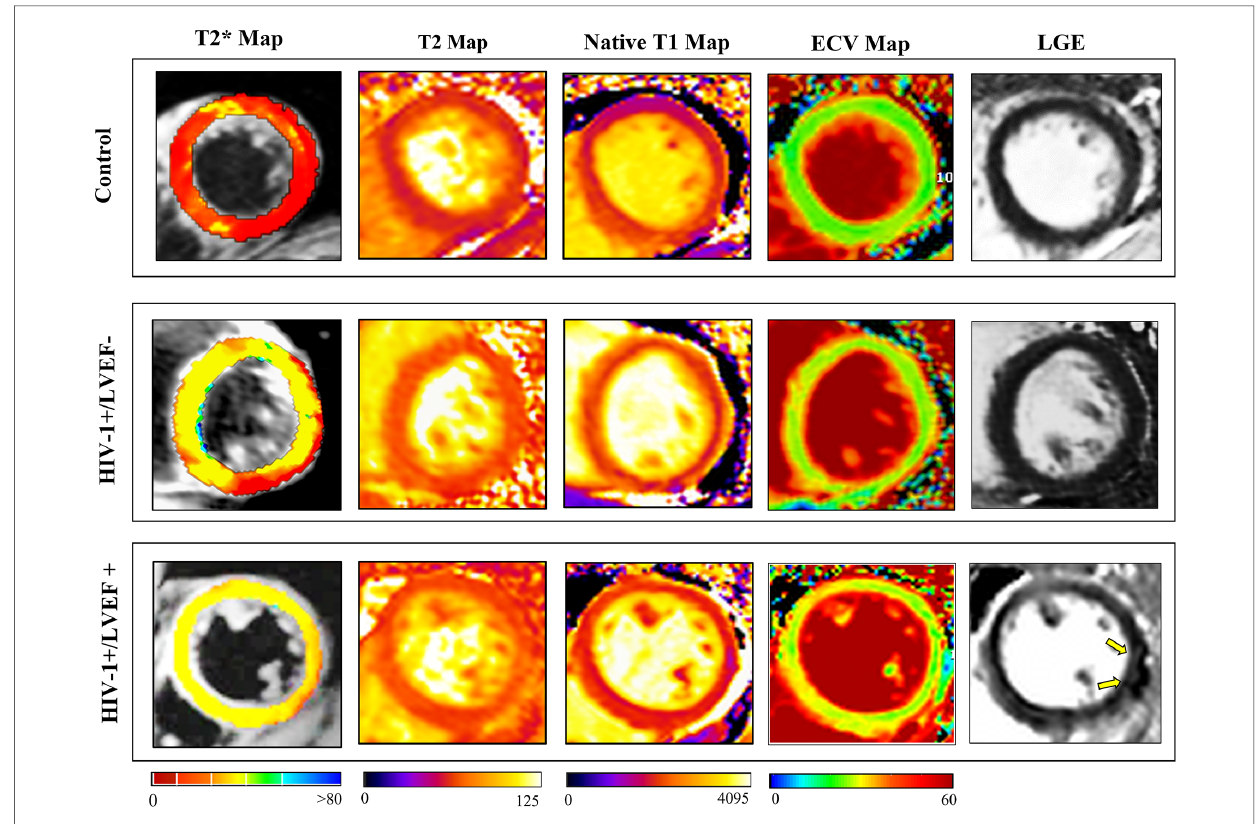
FIGURE 2 Representative clinical examples of CMR images (T2*, T2, T1 native, ECV and LGE) obtained from a healthy subject (control, 35-year-old male), LVEF= 60.3% (top row), a HIV-infected patient (30-year-old male, with preserved LVEF (55.6% (middle row)), and a HIV-infected patient (34-year-old woman with LV dysfunction (LVEF=45.1%) (bottom row). Quantitative parameters are considerably higher in HIV-infected patients and increase proportionately with increasing severity of left ventricular ejection fraction (LVEF), LGE showed patchy enhancement in HIV-1+/LVEF+ patient (yellow arrows). Abbreviations as in Figure 1